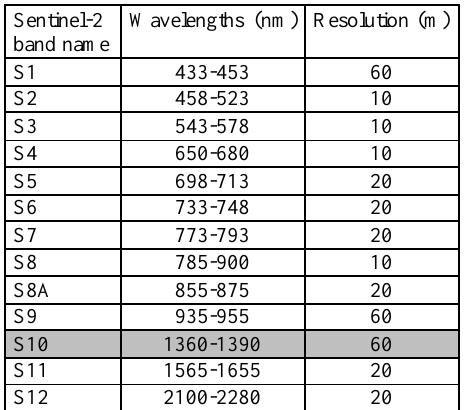
Table 2 . Spectral specificities of the Sentinel-2A MultiSpectral Imager (S10 is disqualified in the study).